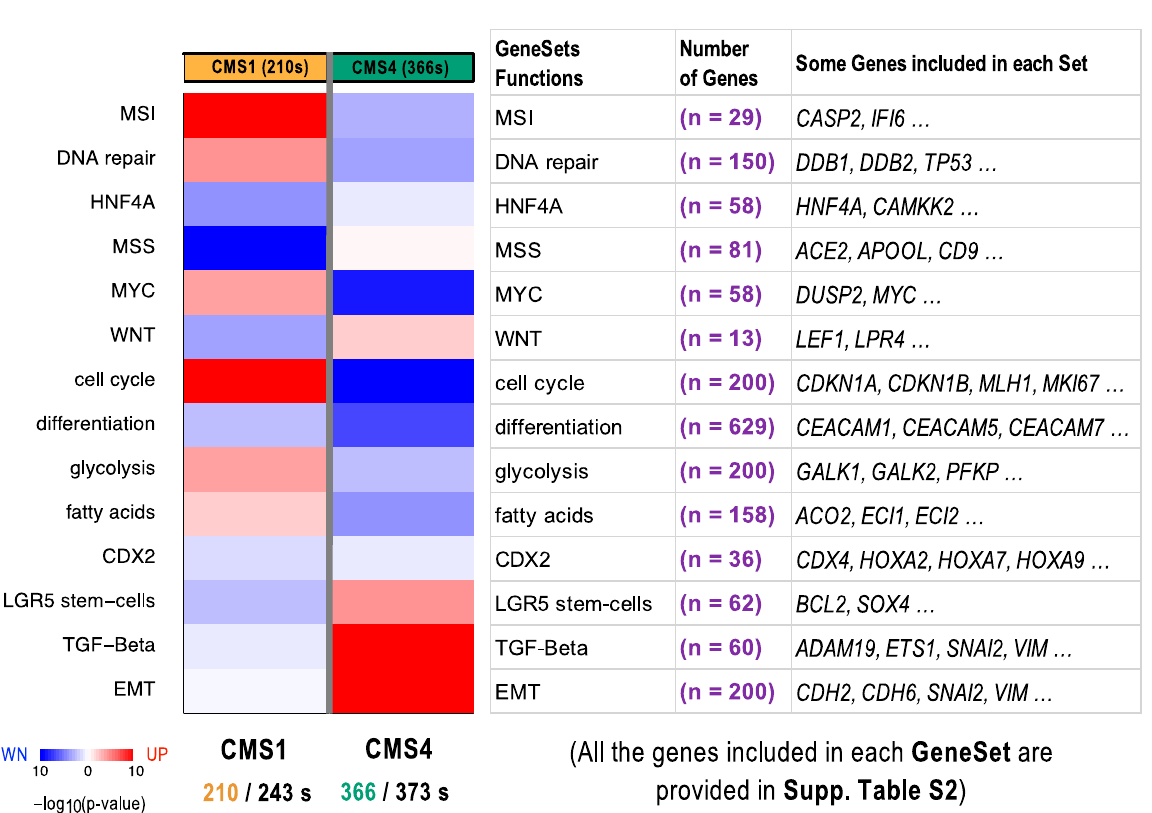
Figure 7. Functional enrichment analysis of the genes included in the CRC subtypes CMS1 and CMS4 based on the gene expression profile of the patients assigned to these two subtypes. All the genes included in each functional gene set are provided in Supplementary Table S2. MSI: microsatellite instability; MSS: microsatellite